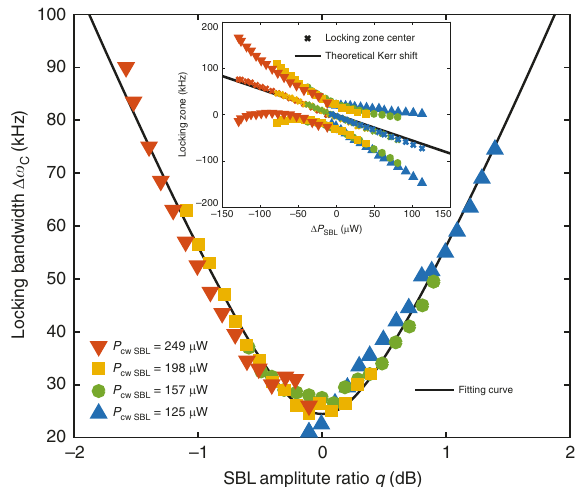
Fig. 3 Locking zone bandwidth versus SBL amplitude ratio. Measured locking zone bandwidth is plotted versus amplitude ratio q of the SBL lasers. The cw power is held constant at four values (see legend) to create the data composite. The solid black curve is Eq. (5). Inset: the measured locking zone boundaries are plotted versus the SBL power differences ¼ P (cid:2) P ( P ). Colors and symbols correspond to the main panel. The SBL ccw cw center of the locking zone is also indicated and is shifted by the Kerr nonlinearity which varies as the SBL power difference. Black line gives the theoretical prediction (no free